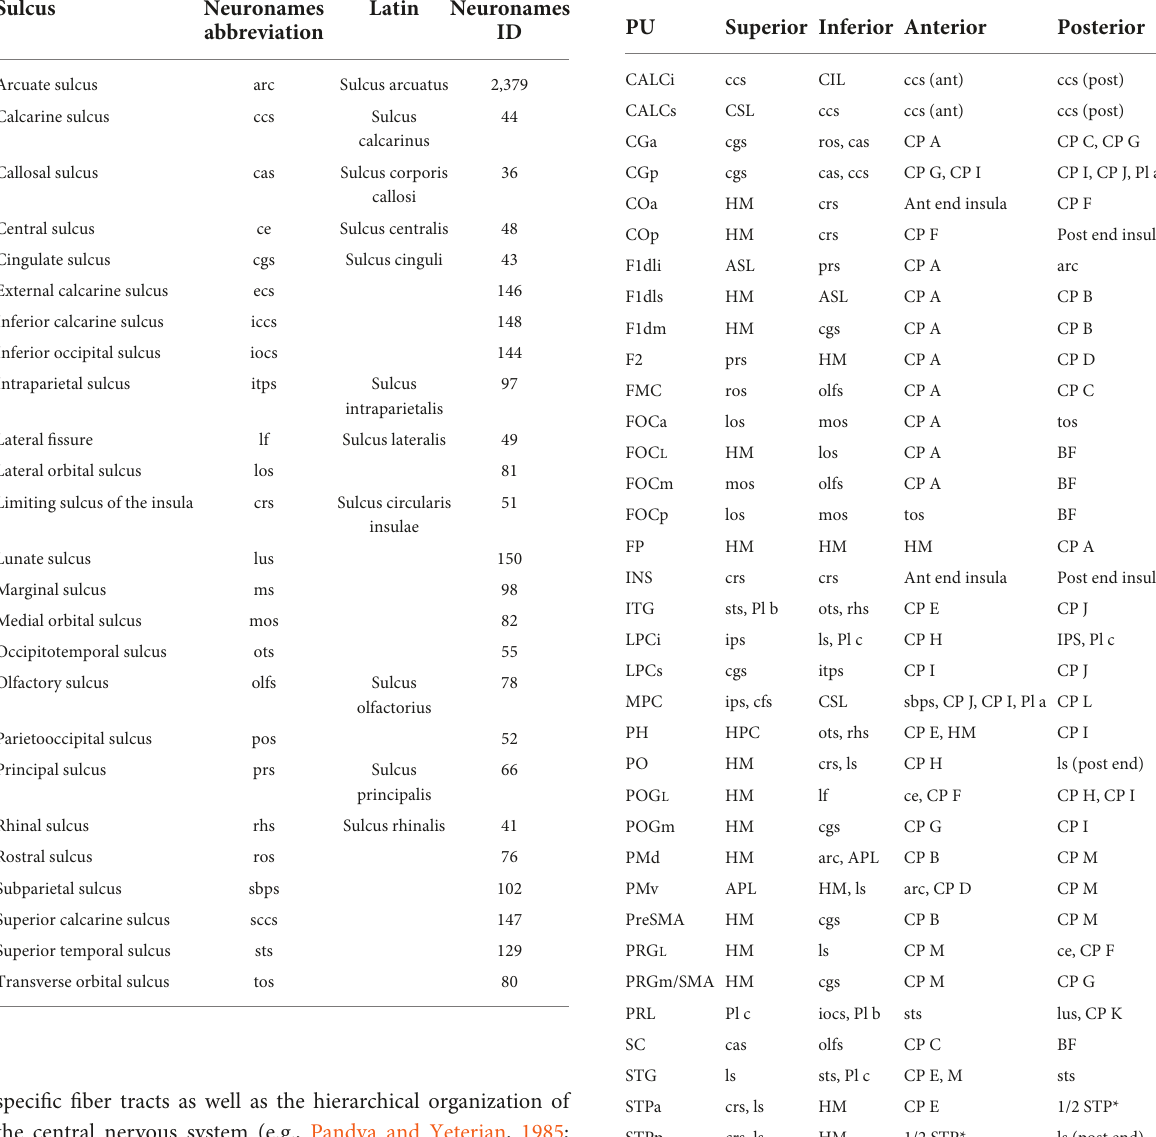
TABLE 8 Limiting Sulci in the macaque Harvard-Oxford Atlas (mHOA). TABLE 9 Macaque Harvard-Oxford Atlas (mHOA) parcellation unit definitions.